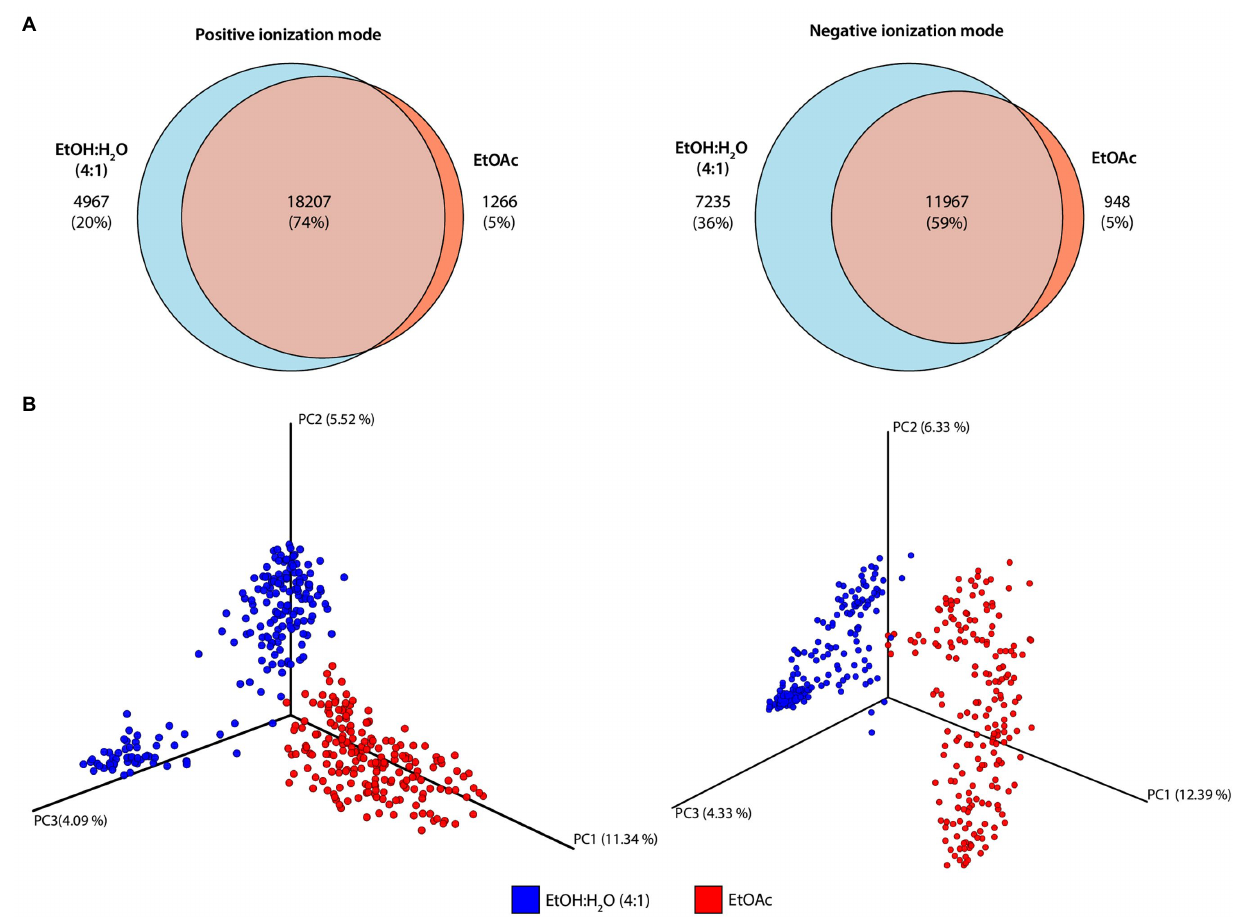
FIGURE 3 | Diversity of metabolic profiles obtained in different extraction protocols and ionization modes. (A) Venn diagrams obtained for the different extraction protocols in positive and negative ionization modes. (B) Three-dimensional Principal Coordinates Analysis (PCoA) plots of the samples analyzed in different ionization modes (positive: left; negative: right) determined by Bray–Curtis distance metric. The percentage of variance explained by the principal coordinates is presented on each